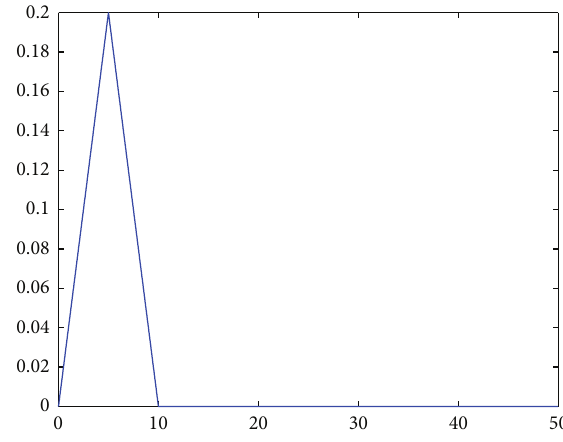
Figure 3: Figure of the probability density function 𝑄 3 .